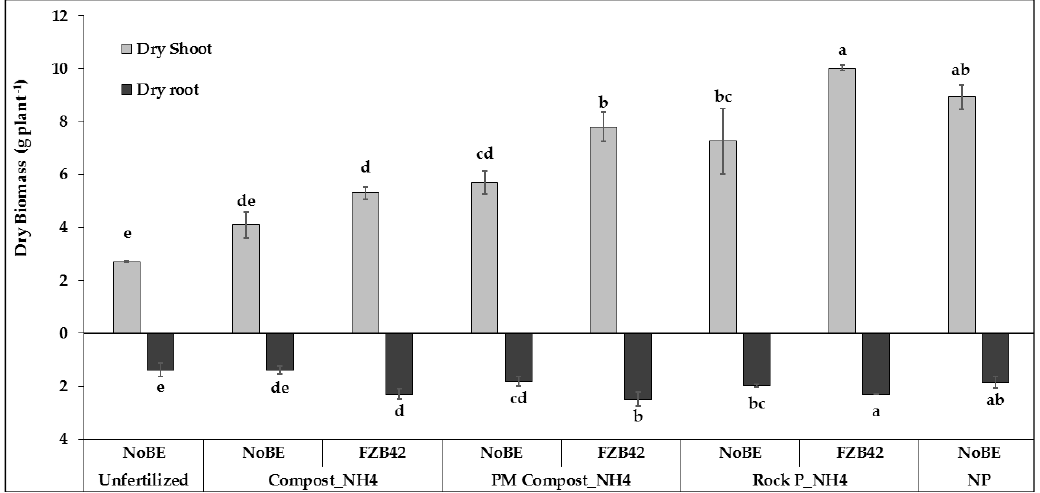
Figure 6. Shoot and root dry weight of 5-week-old tomatoes with FZB42 and different P sources and ammonium sulfate under acidic soil conditions (PM = poultry manure, NP = calcium nitrate plus superphosphate. Means and SE of four replicates. Significant treatment differences are indicated by different letters (T-grouping (LSD) at p = 0.05). * = significant difference compared with the non-inoculated control (NoBE) within the same fertilizer treatment ( t -test at p < 0.05).